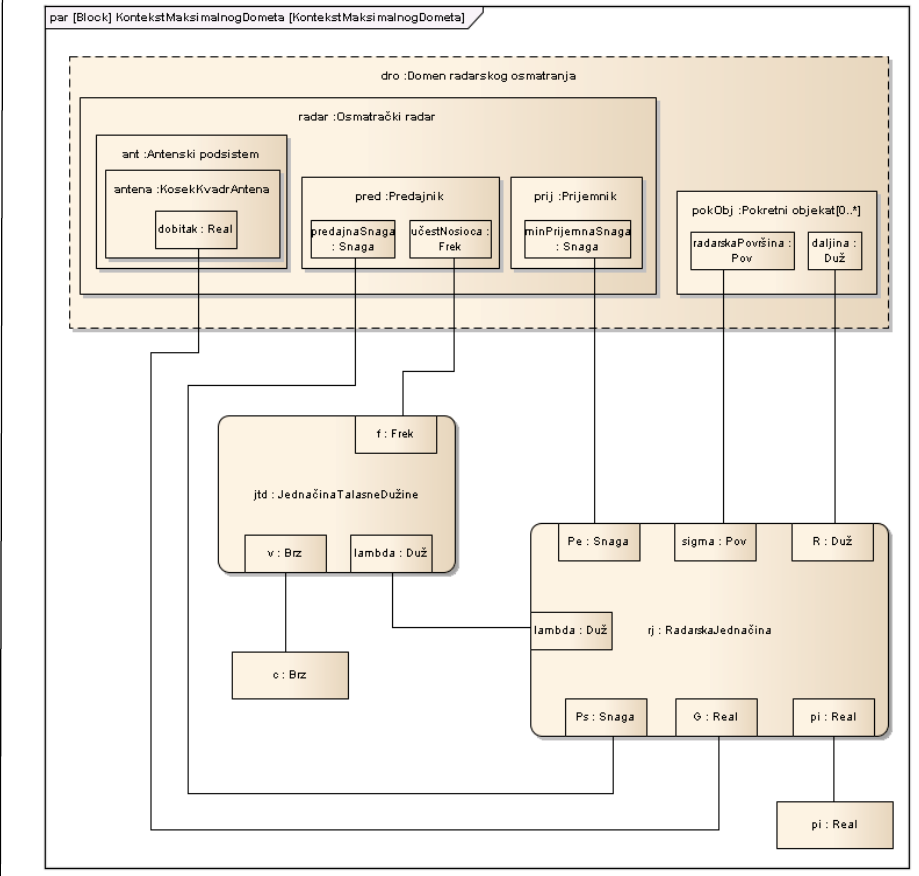
Рис . 10 – Математические отношения , связанные с анализом максимального диапозона радиолокационного наблюдения Figure 10 – Mathematical relations for the maximal range